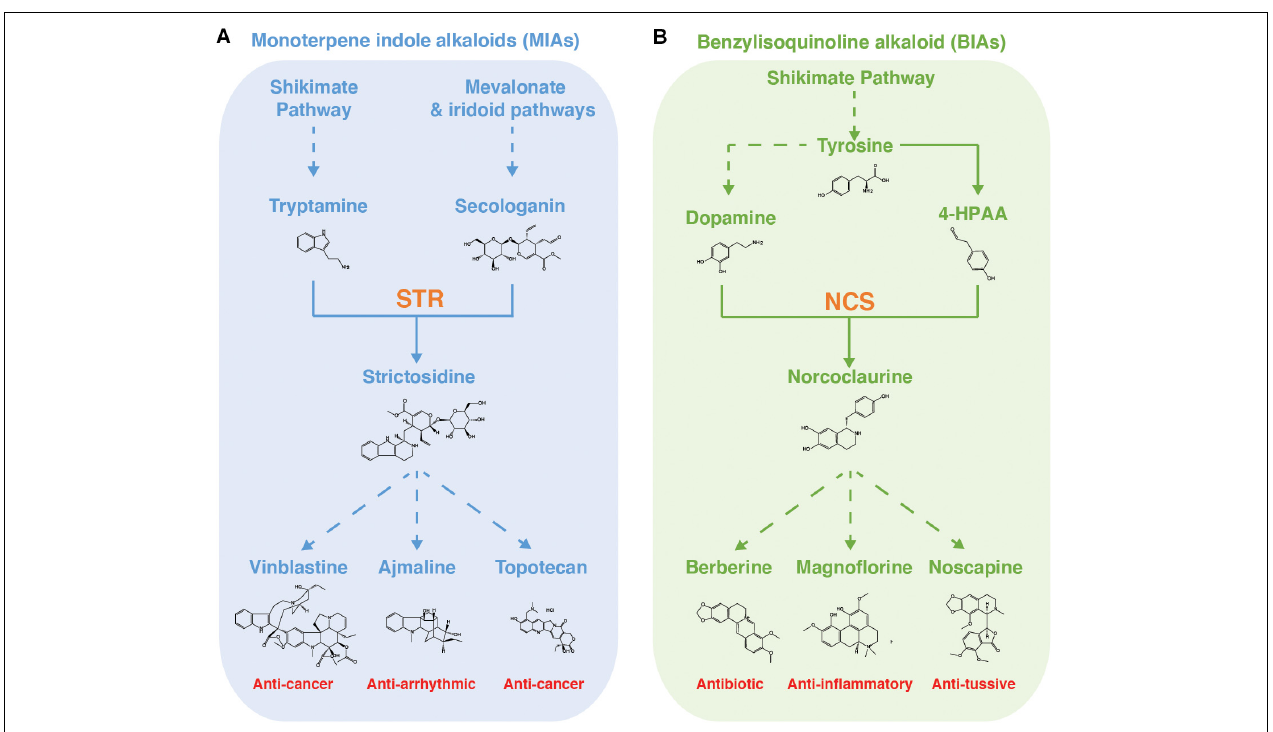
FIGURE 3 | MIA and BIA biosynthetic pathways in yeast. Summaries of the (A) monoterpene indole alkaloid biosynthetic pathway, as refactored in yeast, and (B) benzylisoquinoline alkaloid biosynthetic pathway, with example compounds and, in red, their pharmaceutical applications. STR, strictosidine synthase. NCS, norcoclaurine synthase. Solid arrow denotes single reaction. Dashed arrow denotes multiple